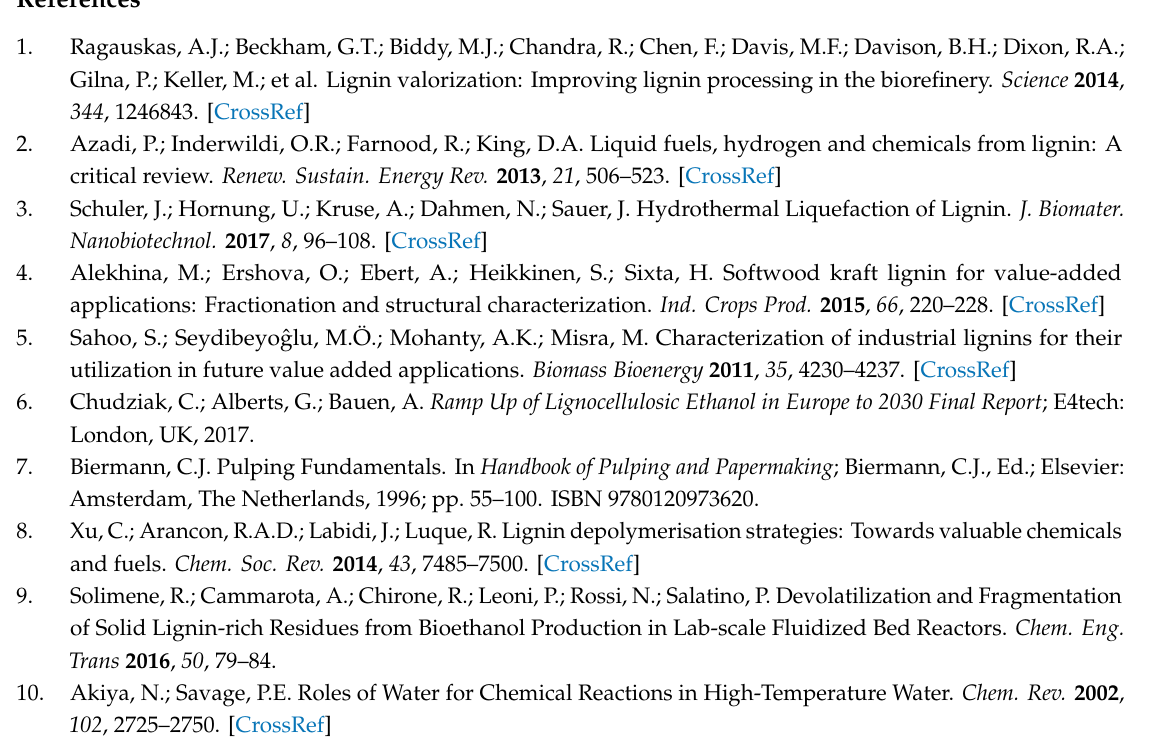
Figure S1: Water-soluble compounds in LRS liquid fraction of the slurry: yield on feed at 10 wt. % and 20 wt. % of B / W, Table S1: Compounds calibrated in GC-MS and HPLC, Table S2: Yields of the HTL products from all investigated reaction conditions. Absolute standard deviation is reported in brackets, Table S3: Qualitative analysis of a light biocrude sample produced at 350 ◦ C, 10 min, 10 wt. % (procedure 1), Table S4: GC-MS - light biocrude (BC1), Table S5: HPLC - aqueous phase